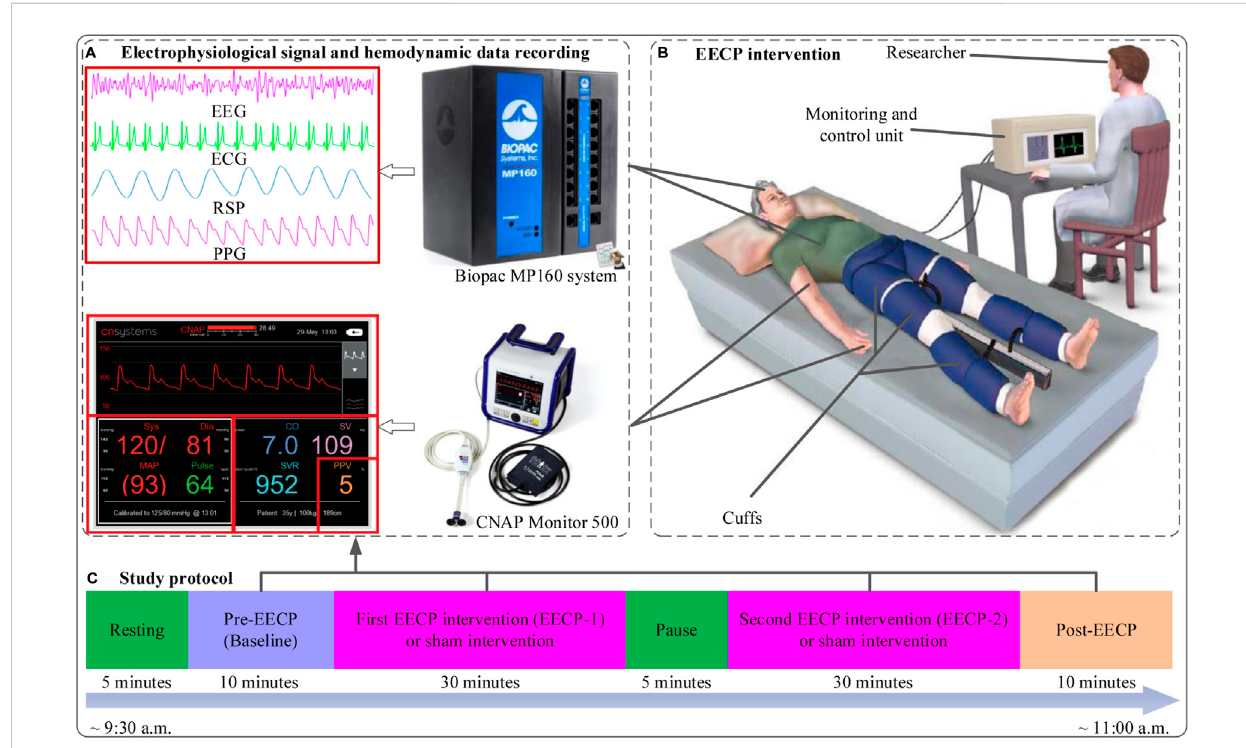
FIGURE 1 The study protocol, fl ow chart of enhanced external counterpulsation (EECP) intervention, physiological signal and hemodynamic data acquisition (A) Electrophysiologicalsignals(EEG,ECG,RSPandPPG)andhemodynamicdata(SBP,DBP,MAP,CO,CI,SVVandSVR)recording (B) EECPinterventionin sham (with pressure set at 0 MPa) and active (with pressure set at 0.020 MPa) groups (revised based on the fi gure from https://edtreatment.info/ enhanced-external-counterpulsation-eecp-therapy-for-erectile-dysfunction/) (C) Study protocol: about 90 min including resting (5 min),